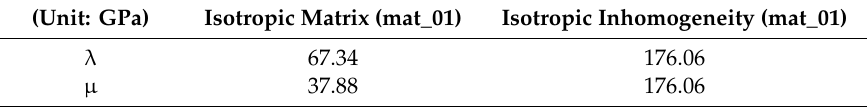
Table 1. Material properties of the isotropic matrix and the isotropic inhomogeneity. Table 2. Material properties of the isotropic matrix and the isotropic and orthotropic cubic inhomogeneity.